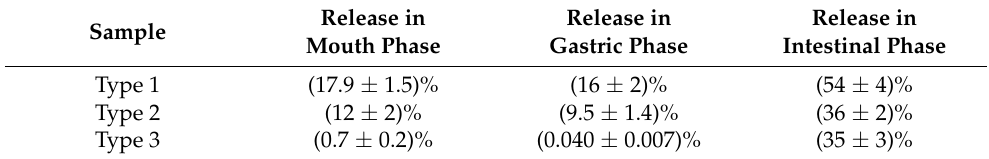
Table 4. %HT release at the end of the three phases of the digestion.